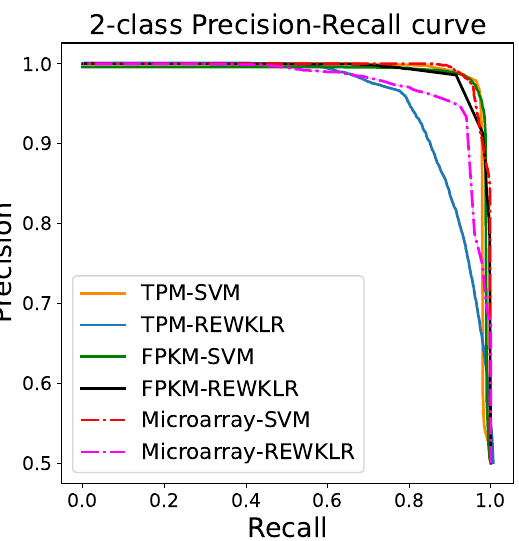
Figure 4. ROC curve for training data showing in general the recall is increased at a low fallout.